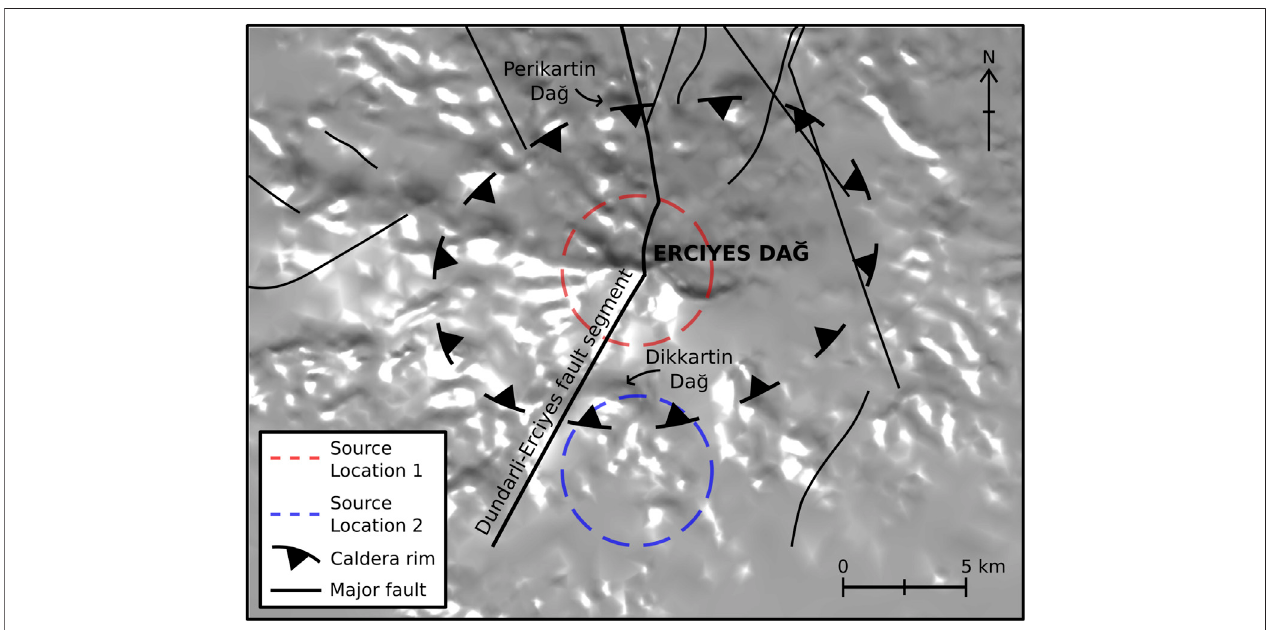
FIGURE 9 | Volcano-tectonic map of Erciyes Da ğ and surface projections of explored magma reservoirs (to scale). Dikkartin Da ğ and Perikartin Da ğ , the two most recenteruptivecentresofthevolcaniccomplexarelocatedalongtheDundarli-Erciyesfaultsegmentandnearthesegment ’ sintersectionswiththesouthernandnorthern caldera rim and caldera boundary faults. Source location 1 marks the surface projection of the model reservoir directly beneath the summit, whereas source location 2 marks a reservoir 5 km to the south of the summit. Data presented in Ş en et al. (2003) was utilised to determine the locations of the caldera rim and major faults.